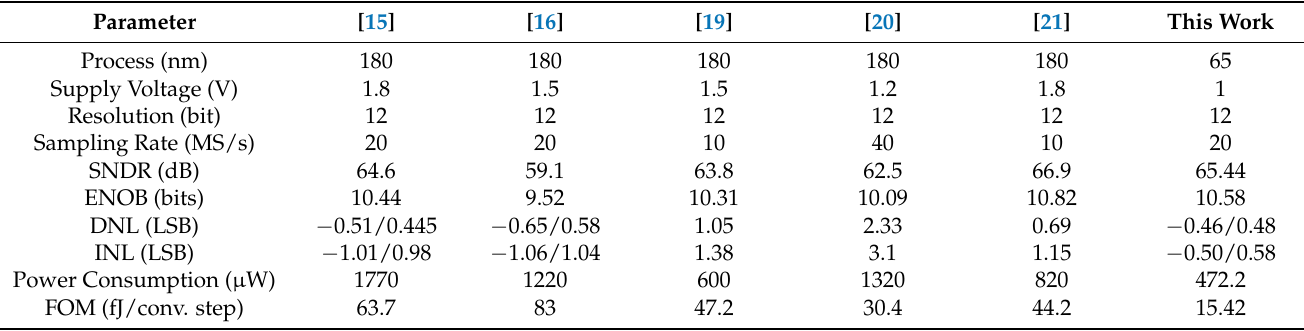
Table 1. Performance summary and